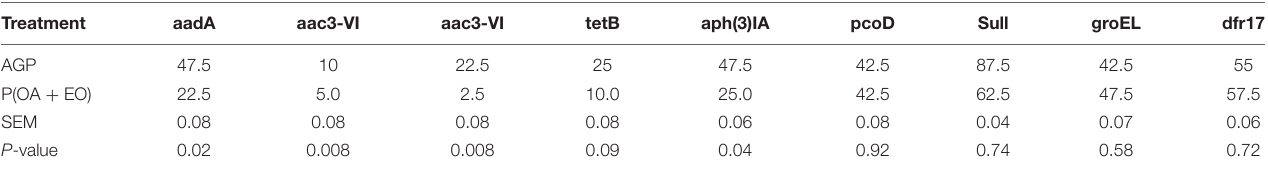
TABLE 2 | Prevalence of antimicrobial resistance genes in the cecal microbiota of broiler chickens supplemented with antibiotic growth promoter (AGP) or protected organic acids (OA) and essential oils (EO) [P(OA + EO)] raised under field conditions. Treatment